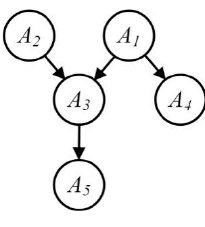
Figure 2. The Bayes network. Table 1. Bayes network parameters.